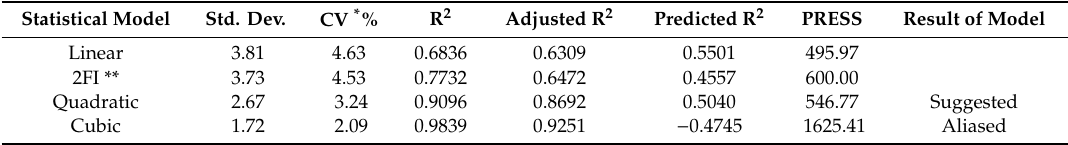
Table 4. Quadratic model statistics.